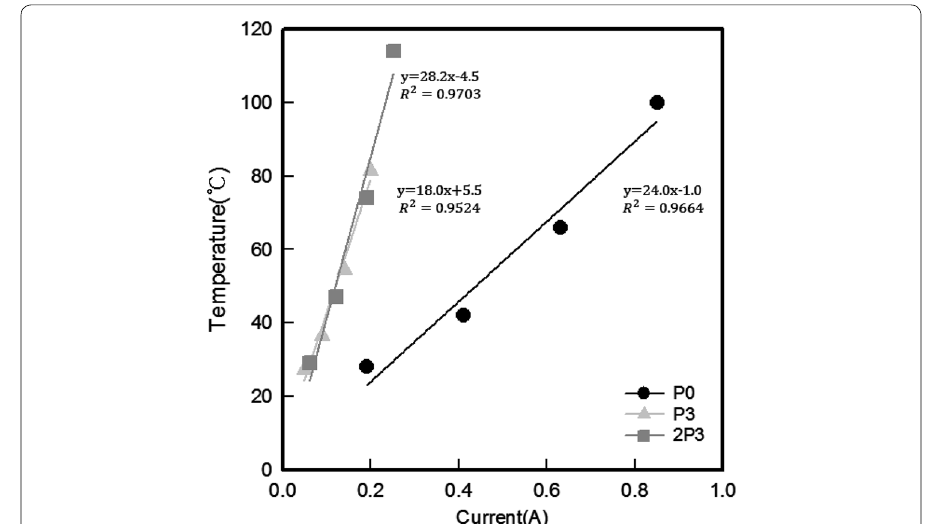
Fig. 5 Current-dependent temperature of CNF/PVDF-HFP composite coated cotton fabrics with various circuit